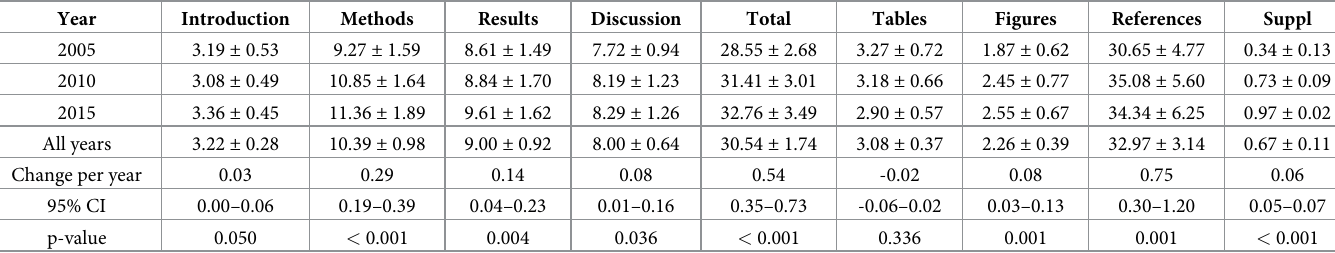
Table 2. Results of meta-analyses per year over journal.